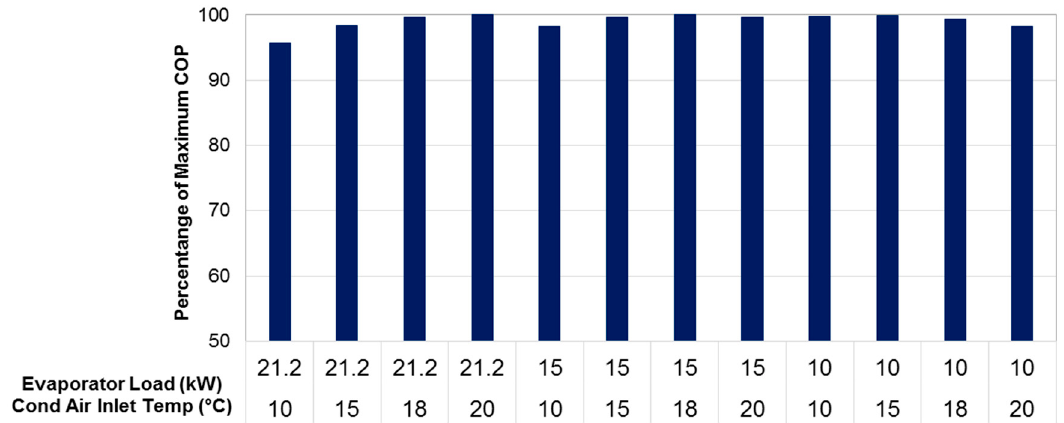
Figure 13. Percentage of maximum COP using condenser ATD of 8 K.